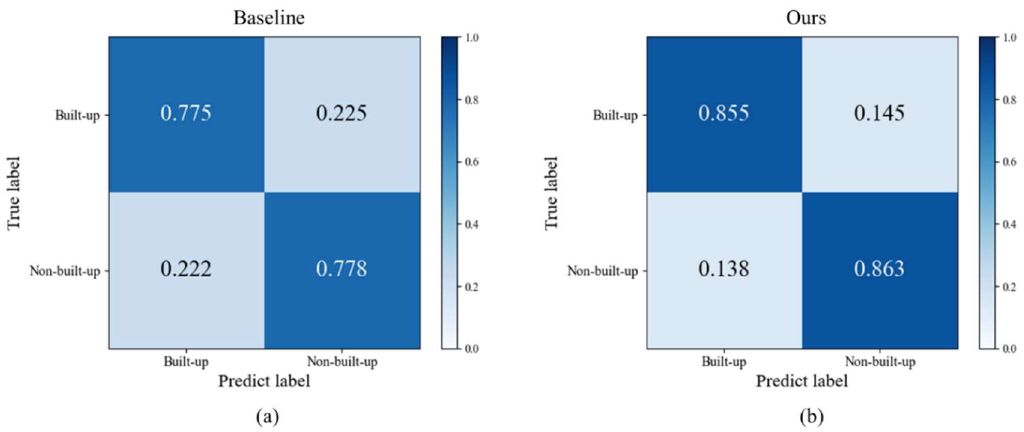
Figure 10. The CMs for different methods in Changsha County. ( a ) Baseline CM. ( b ) Our CM.